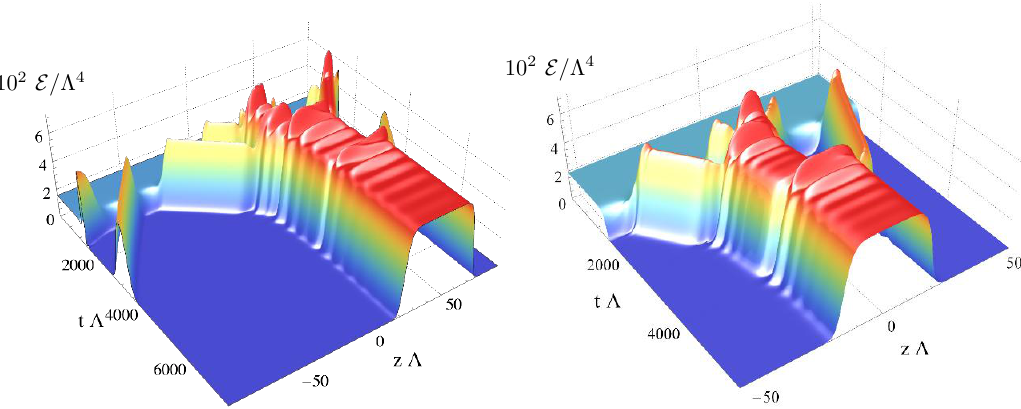
Figure 4 . Spacetime evolution of the energy densities of initial homogeneous states with energies and size boxes E ( t = 0) = E 3 ; L (cid:3) ’ 187 (left) and E ( t = 0) = E 2 ; L (cid:3) ’ 107 (right). The instability is triggered by an initial n = 1 perturbation (left) and by pure numerical noise